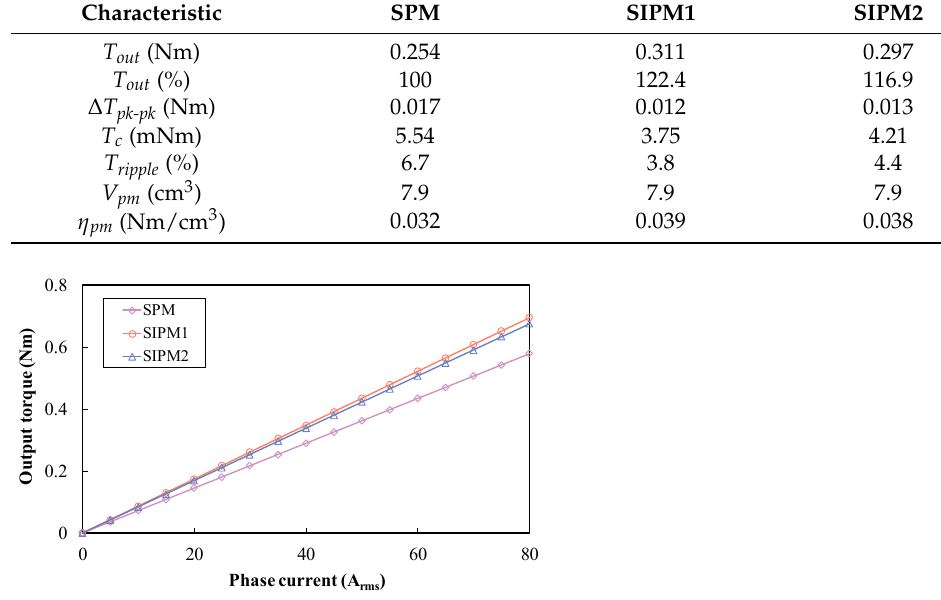
Table 4. Torque characteristic of motors.